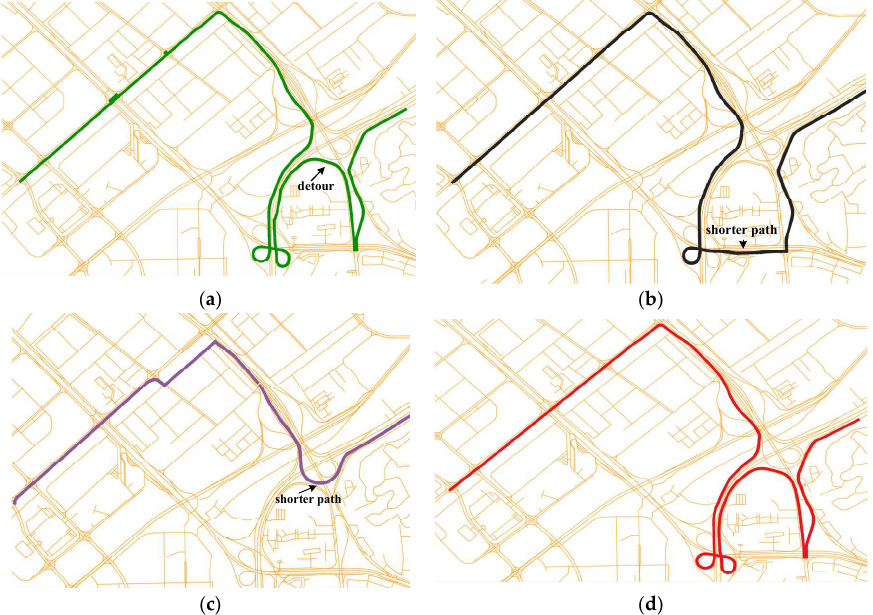
Figure 14. Comparison of matched paths of HTMM and ST-Matching: ( a ) sampling rate of 30 s (real path); ( b ) sampling rate of 60 s (ST-Matching); ( c ) sampling rate of 120–300 s (ST-Matching); ( d ) sampling rate of 120–300 s (HTMM).